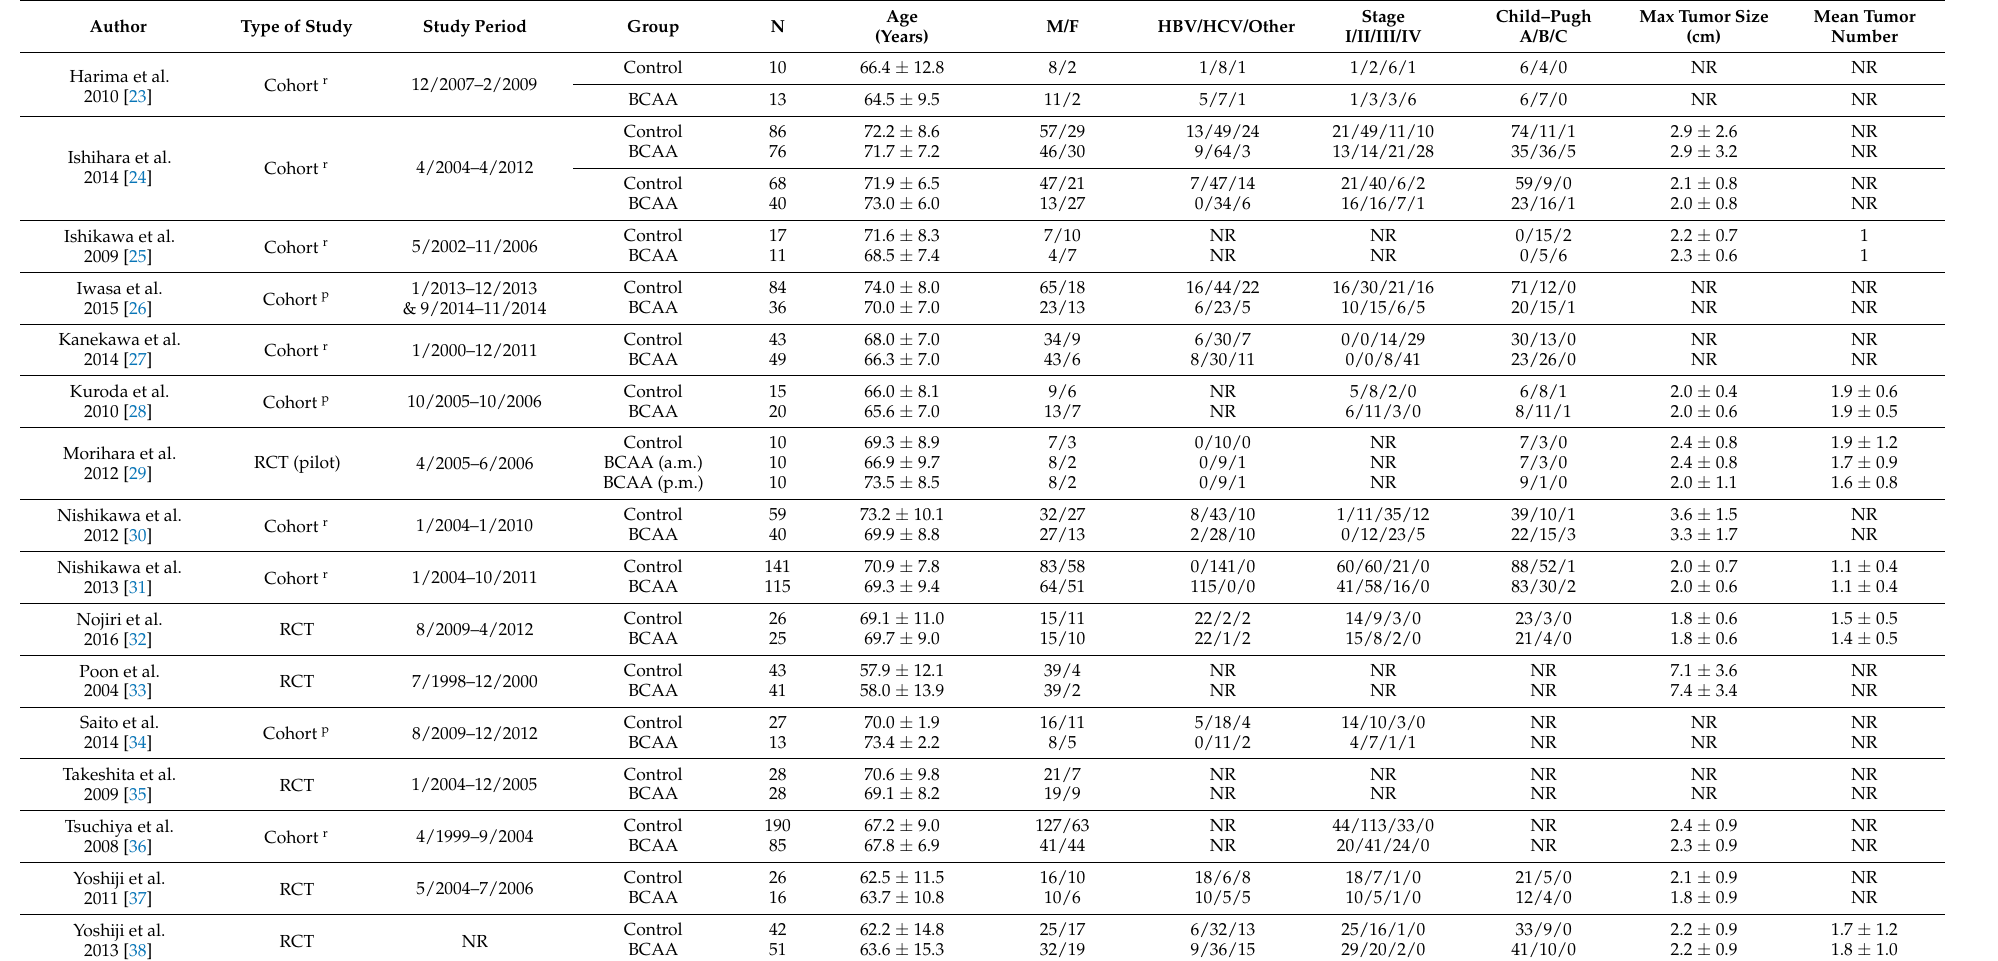
Table 1. List of included studies and baseline demographic